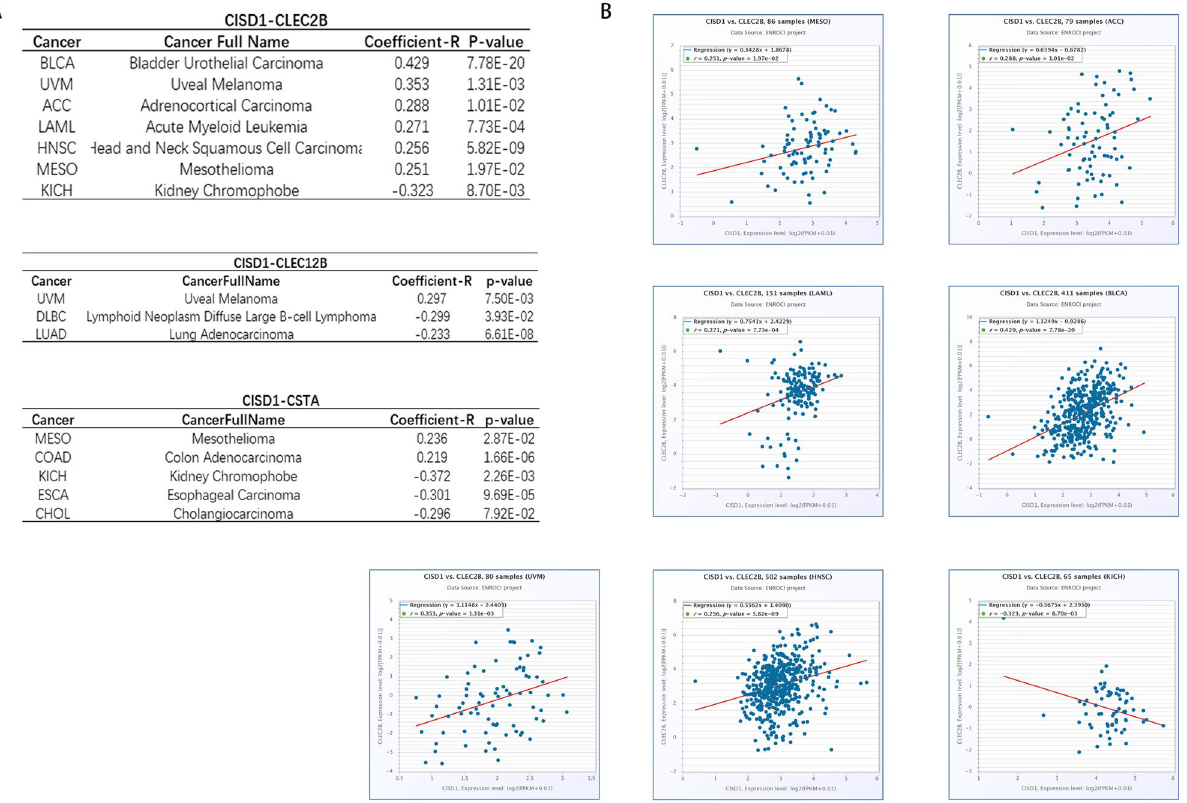
CISD1-CLEC2B co-expression